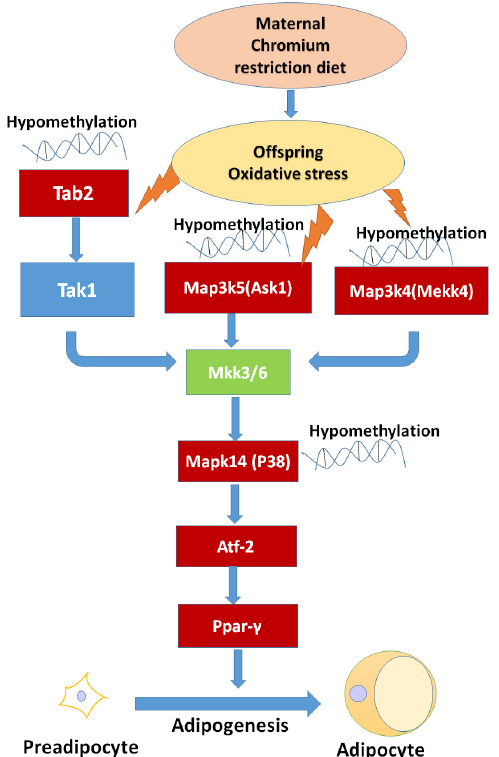
Figure 7. The possible mechanism of maternal chromium restriction on offspring. Maternal chromium restriction induces oxidative stress, then leads to hypomethylate in Map3k5 (Ask1), Tab2 , Map3k4 (Mekk4), Mapk14 (p38 MAPK) promoter, activates Ppar- γ through Atf-2 to accelerate adipogenesis in adipose of mice offspring. The red box indicates hypomethylated gene promoters, and upregulated gene expression. Map3k4: mitogen-activated protein kinase kinase kinase 4; Mapk14 : mitogen-activated protein kinase 14; Map3k5 : mitogen-activated protein kinase kinase kinase 5; Tab2 : TGF-beta activated kinase 1/MAP3K7 binding protein 2; Tak1 : Transforming growth factor- β -activated kinase 1; Ask1 : apoptosis signal-regulated kinase 1; Mkk3/6: mitogen-activated protein kinase kinase 3/6; Ppar γ : peroxisome proliferator activated receptor gammas; Atf2 : activating transcription factor